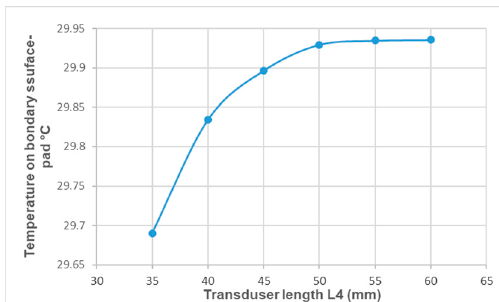
Figure 8. Influence of length L 4 on the temperature on the boundary between the tissue surface and the transducer